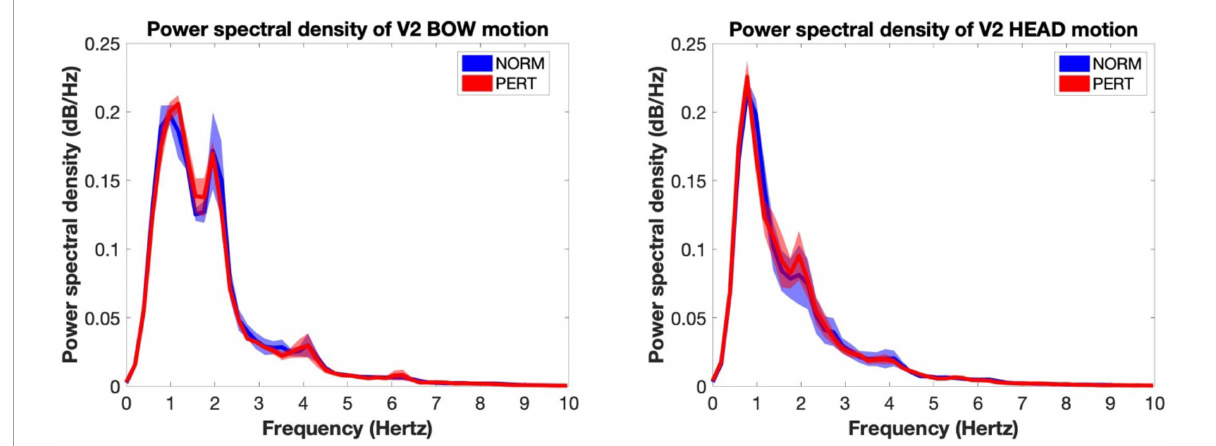
FIGURE6 Power spectral density of the motion of the bow (Left) and the head (Right) of V2 for each experimental condition (shaded areas represent inter-subject standard error). The frequency composition of the bow motion was concentrated around 1 and 2 Hz (reflecting whole and half notes) with peaks near 4 and 8 Hz (quarter and eighth notes). The motion of the head as dominated by a component situated near 1 Hz, with an important secondary component near 2 Hz and a tiny peak near 4 Hz. No change was observed across conditions. Importantly, this frequency composition hardly explains the shift observed in V1 during perturbation, when they were facing V2.